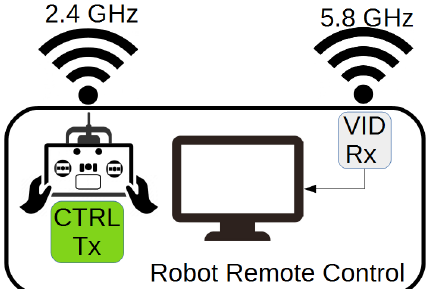
Figure 10. Mobile platform remote control panel.